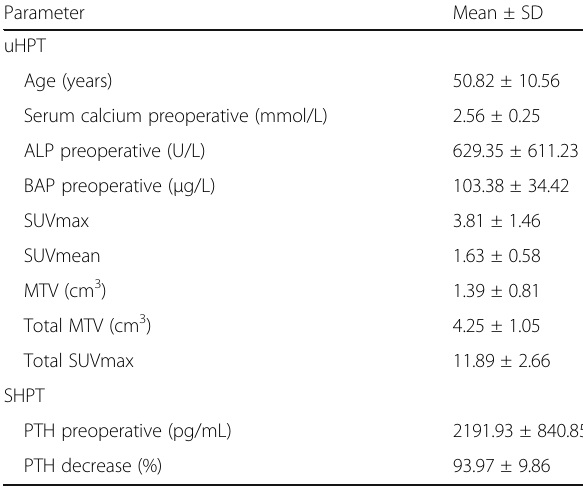
Table 1 Characteristics of the patients enrolled in the study